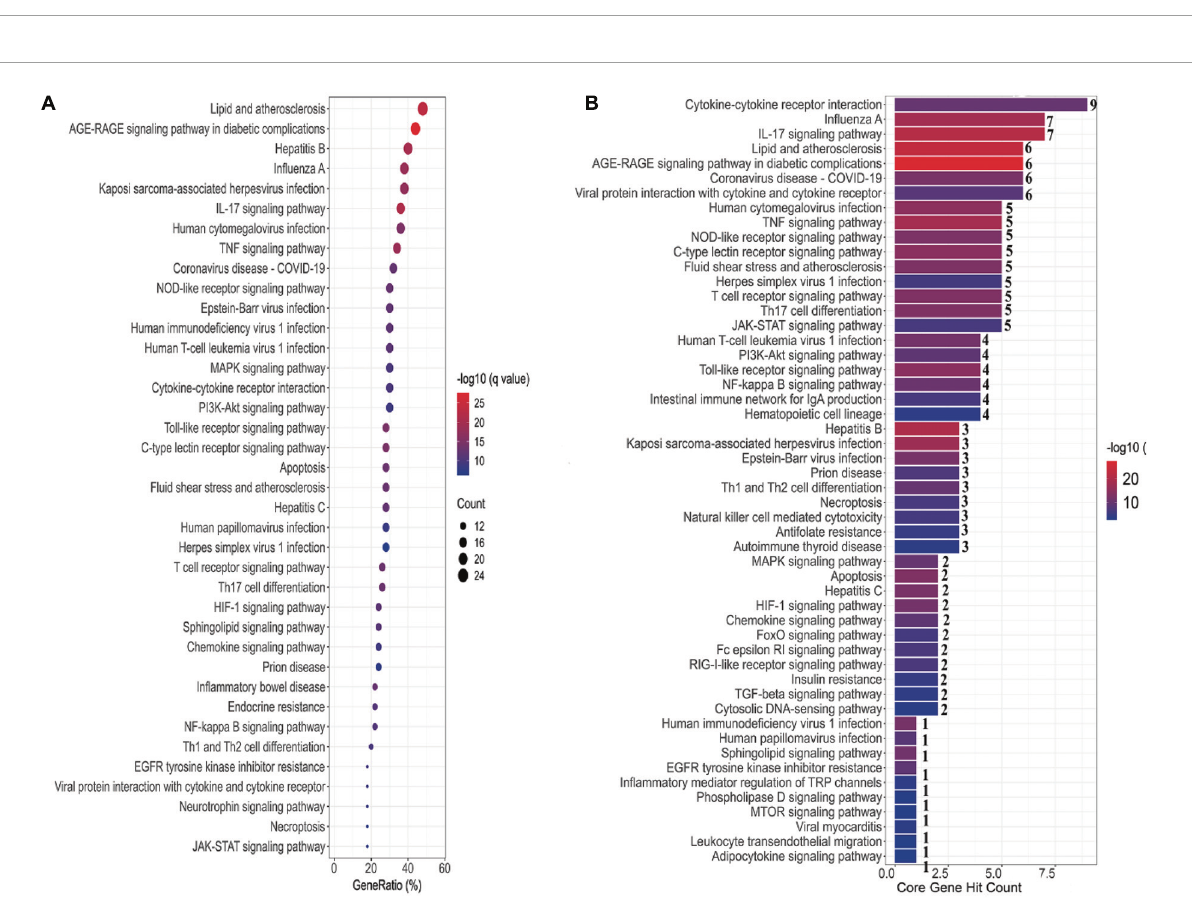
FIGURE6 Pathway enrichment analysis and pathway hit to hub genes. (A) The top 39 signaling pathways associated with 51 potentially acting target genes. Pathways with a P -values < 0.05 were identified. The spot size represents the number of genes, and the color represents the P -value. The horizontal coordinate represents the generation, which is the ratio of the number of intersecting genes enriched in the pathway to the total intersecting genes; the vertical coordinate represents the name of the enriched pathway. (B) Signaling pathways associated with hub genes. The horizontal coordinate represents the number of hub gene hits on the pathway, and the vertical coordinate represents the pathway